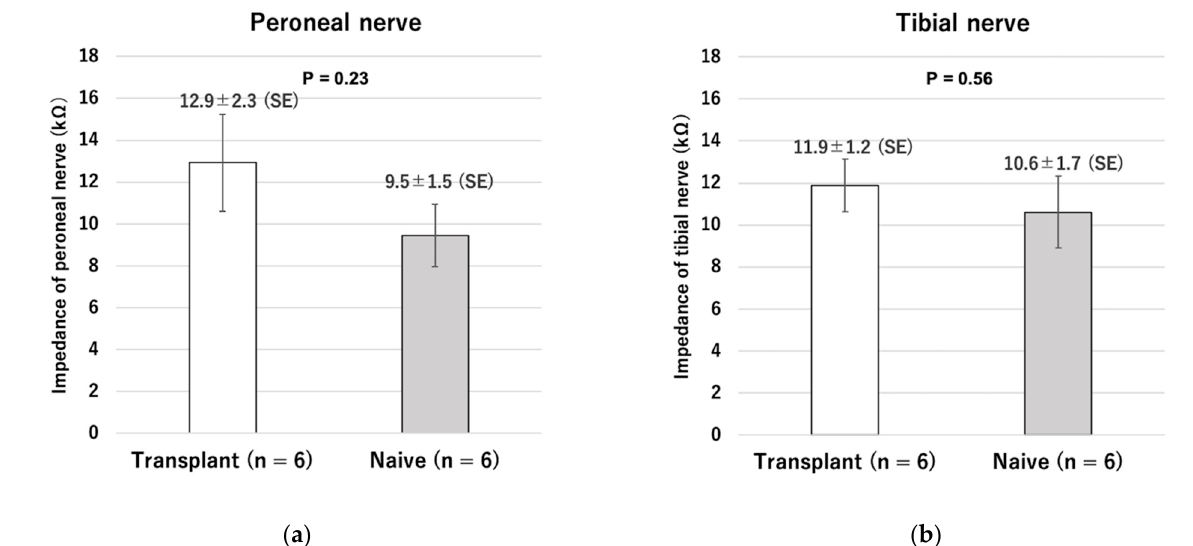
Figure 8. Amount of current applied to attain the maximum ankle angle. ( a ) For maximum dorsiflexion while stimulating the peroneal nerve. ( b ) For maximum plantarflexion while stimulating the tibial nerve.